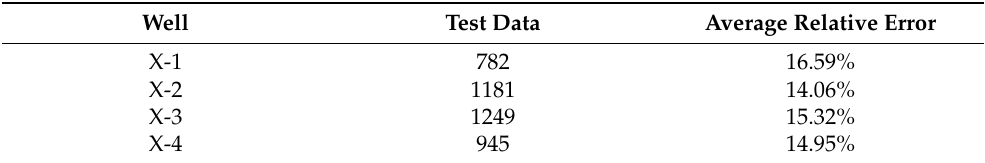
Figure 18. Comparison of ROP prediction and actual value: ( a ) Well X-1, ( b ) Well X-2, ( c ) Well X-2 and ( d ) Well X-4. Table 5. Relative error of multi-well prediction results.